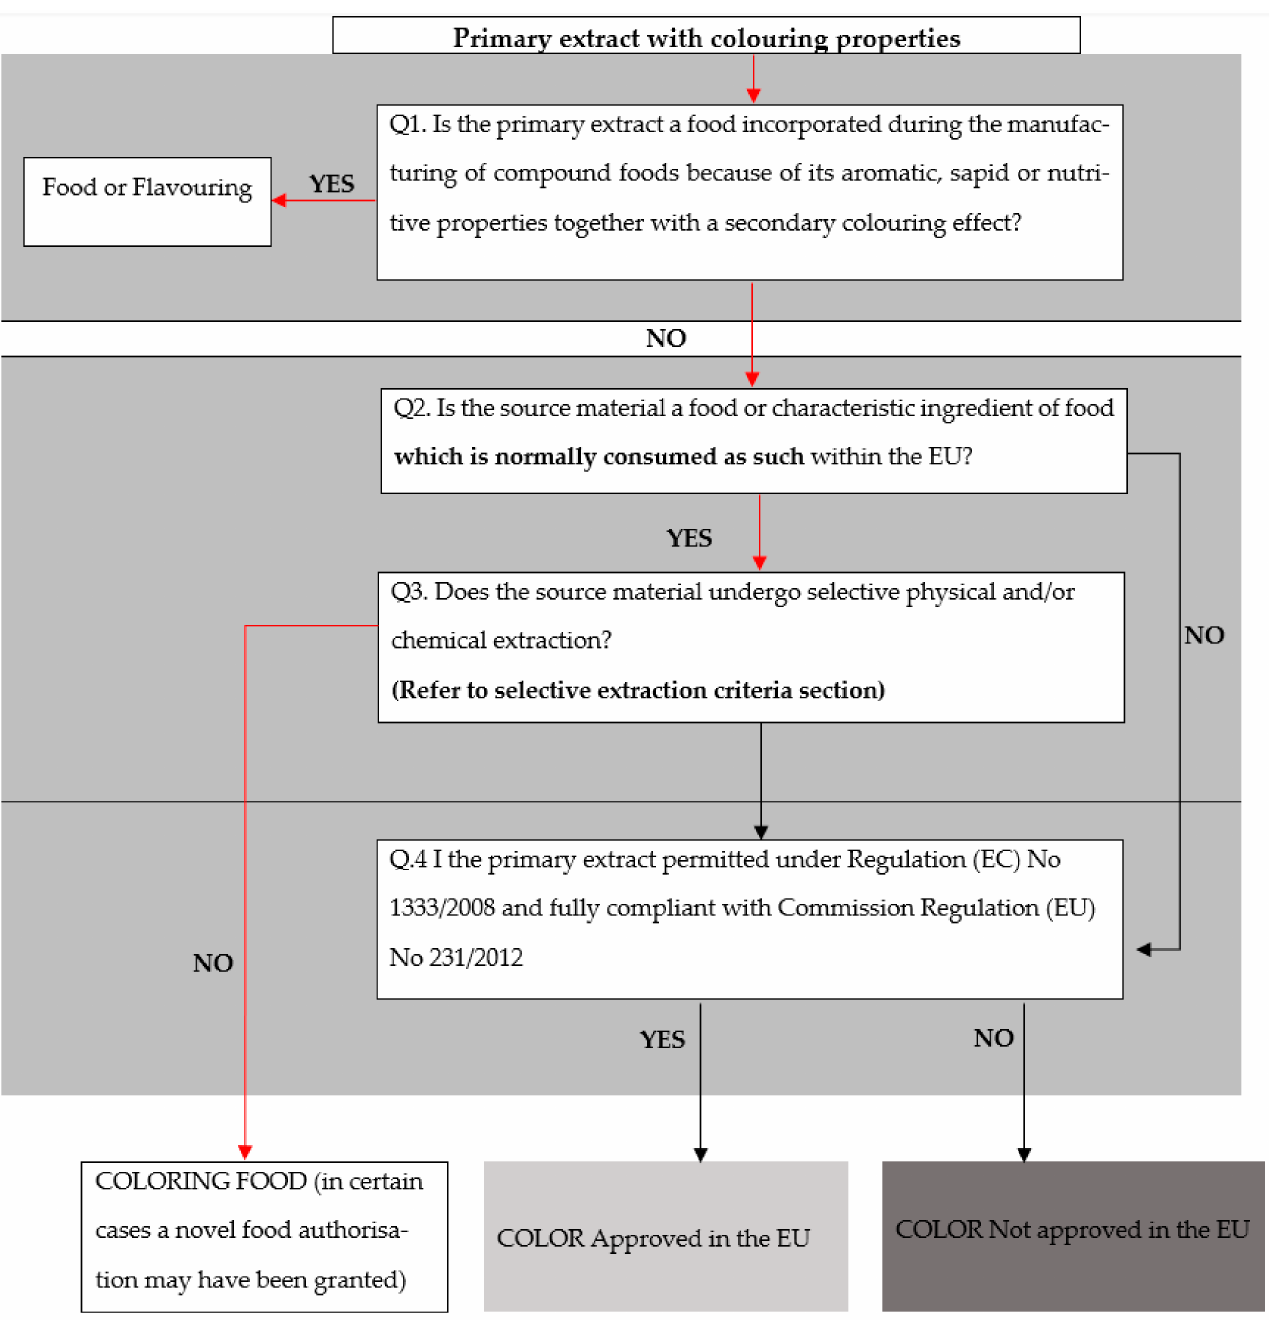
Figure 3. Decision tree for the classification of